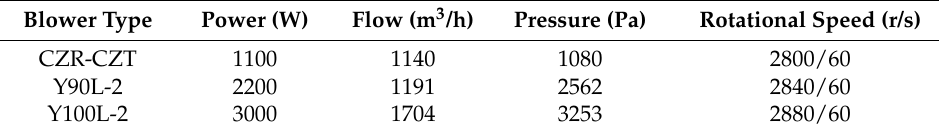
Table 1. Parameters of the high-pressure blower.